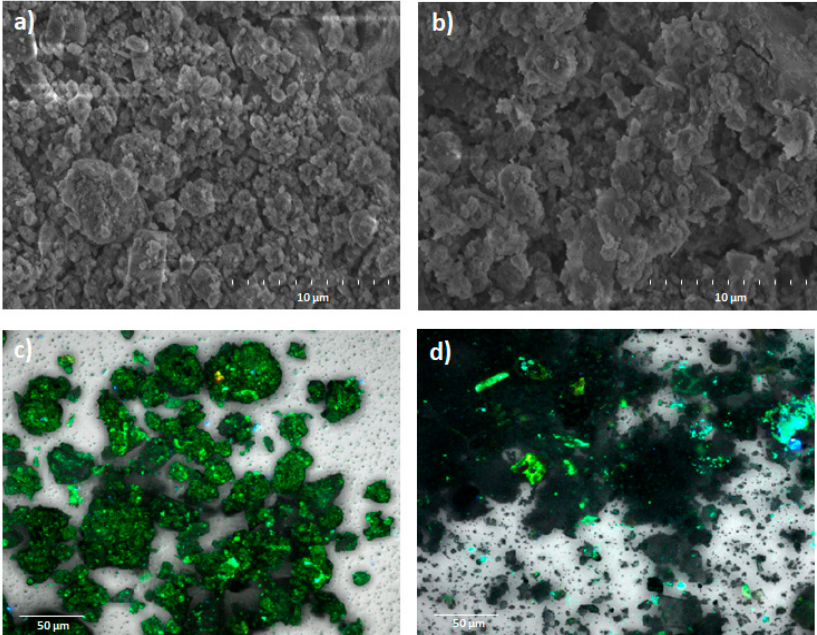
Figure 1. SEM analysis to soil with ( a ) total organic matter (T-OM) and ( b ) partial removal of organic matter (R-OM) and confocal images to soil with ( c ) T-OM and ( d ) R-OM. 3.2. H 2 PO 4 − Adsorption on Soils with and without Cu 0 or Ag 0 ENPs